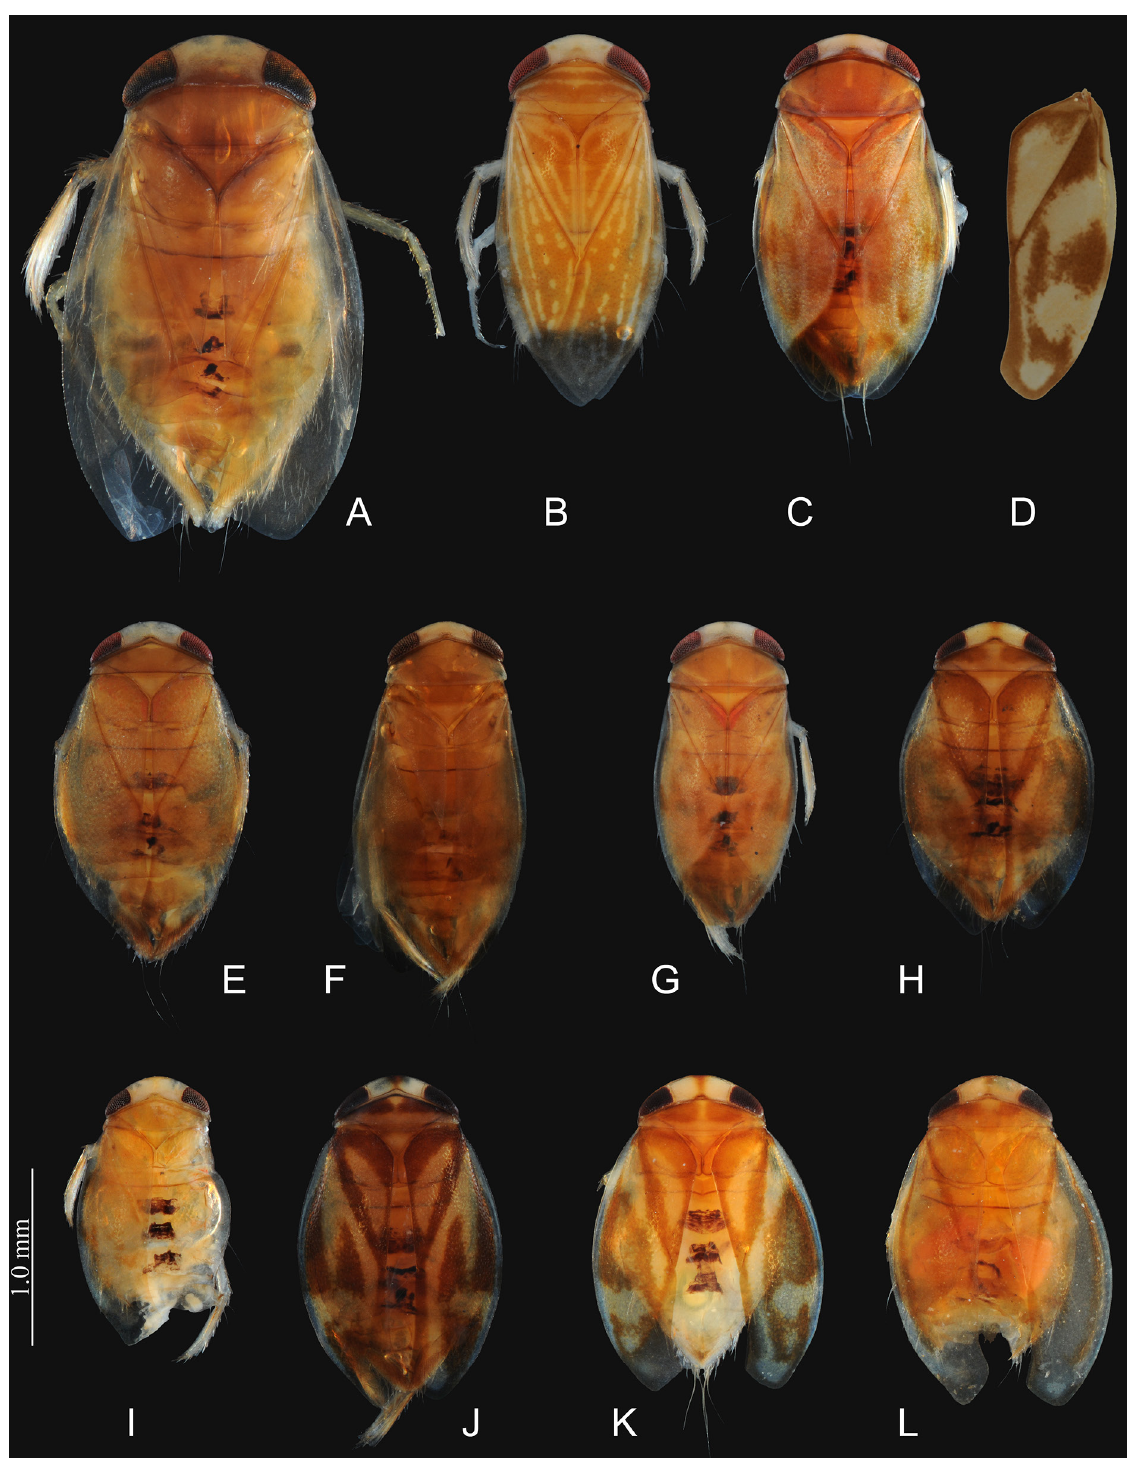
Fig. 5. Habitus photos of species of Micronecta Kirkaldy, 1897, ♂♂. A . M. grisea (Fieber, 1844) (ZRC). B . M. guttatostriata Lundblad, 1933 (ZVNU). C . M . drepani Nieser, 2000 (ZVNU). D . M. erythra Nieser, Chen & Yang, 2005, right hemelytron (ZVNU). E . M. cultellata sp. nov., holotype (ZVNU). F . M. anatolica Lindberg, 1922 (ZVNU). G . M. arcuata sp. nov., holotype (ZVNU). H . M. fulvopicta sp. nov., holotype (ZVNU). I . M. acuminata sp. nov., holotype (ZVNU), right hemelytron and genitalia dissected. J–L . M. vietnamica sp. nov., J = holotype (ZVNU). All to the same